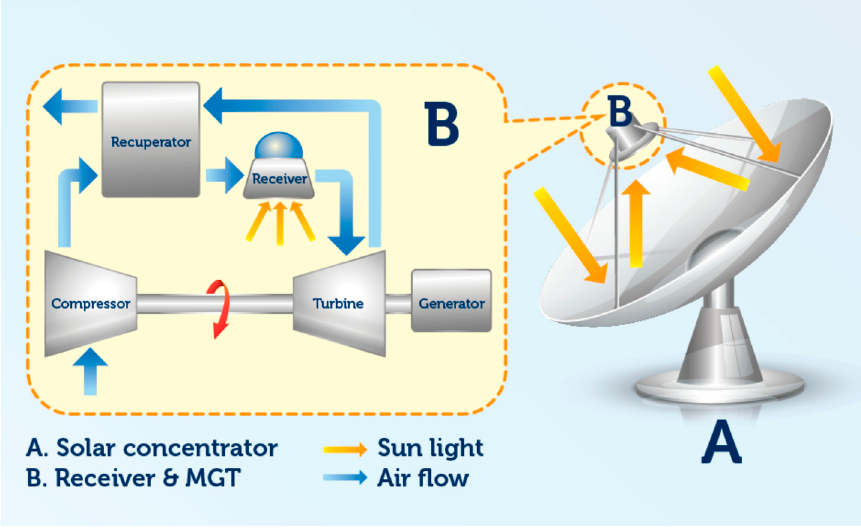
Figure 1. Scheme of a Dish-Micro Gas Turbine concentrating solar power plant [13].